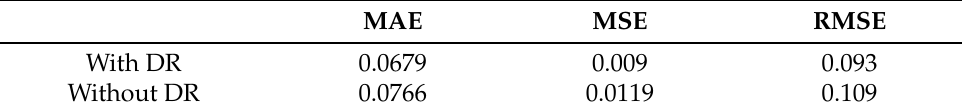
Table 8. MLR with dimensionality reduction: performance of the model on testing dataset.